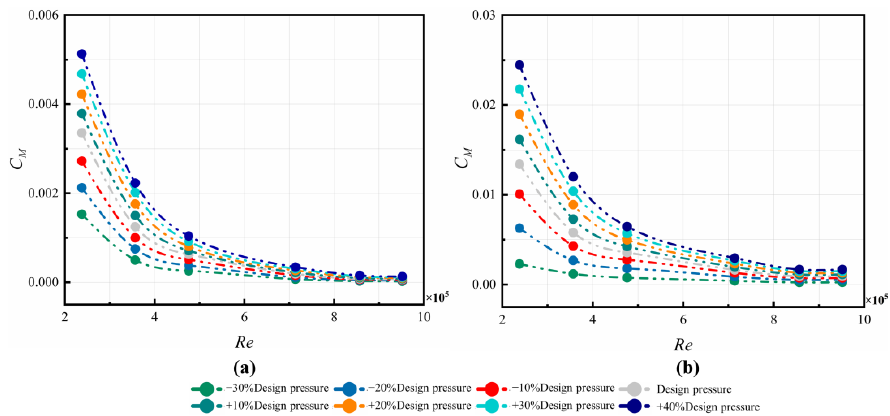
Figure 20. Variations of C M in C3 cavity at different 𝑝 𝑖𝑛,𝑡𝑜𝑡𝑎𝑙 and Re on: ( a ) rotor and ( b ) stator.